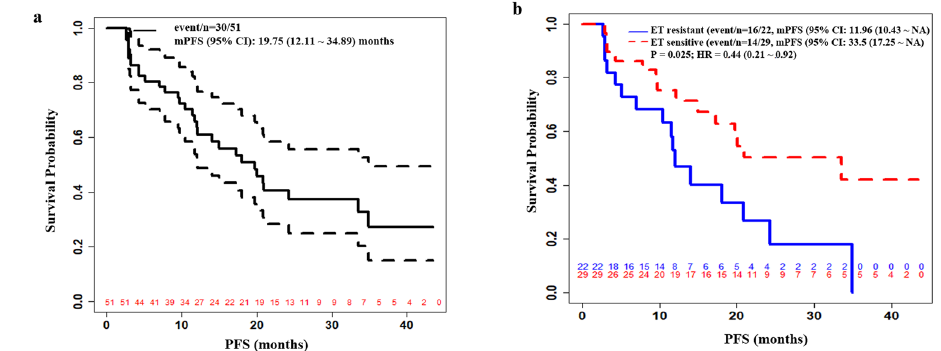
Fig. 1 Progression-free survival (PFS) of all treated patients. a the overall population, and b by endocrine sensitivity.